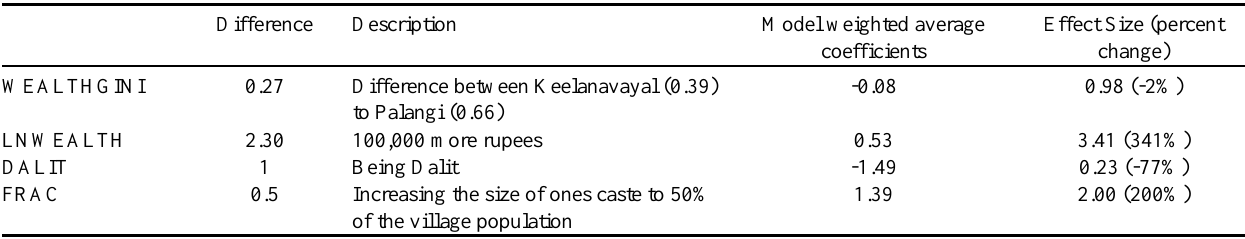
Table 7. CHANNEL effect size calculations. Effect sizes are calculated as e ^ (d•C coefficient, and d = real world difference. Appendix Table A8 presents the original workdays regression and a modified regression with an inequality-adjusted CHANNEL variable. Not surprisingly, the inequality-adjusted CHANNEL workdays regression results are very similar to the original results, suggesting that even when social and wealth inequalities influencing CHANNEL distribution are accounted for, being connected to the irrigation systems still